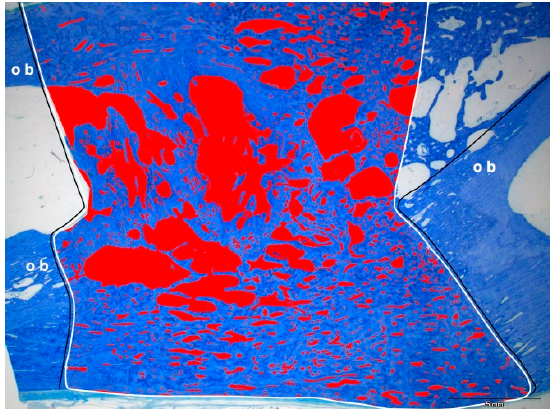
Figure 10. Schematic view of the histomorphometrical analysis. After identification of the original bone (ob), the defect area in between was determined. The area without bone (in red) was measured and subtracted from the total measurement area (in white), resulting in the area of newly formed bone.